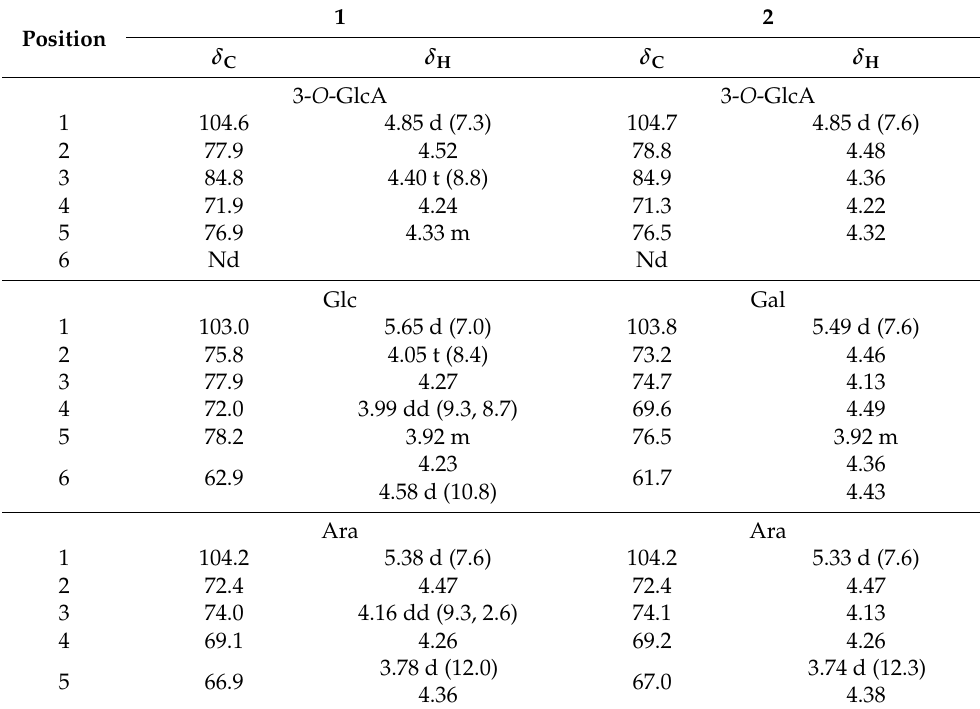
Table 2. 1 H (600 MHz) and 13 C (150 MHz) NMR data of the sugar moieties of compounds 1 and 2 in pyridine- d 5 ( δ in ppm, J in parentheses in Hz) a